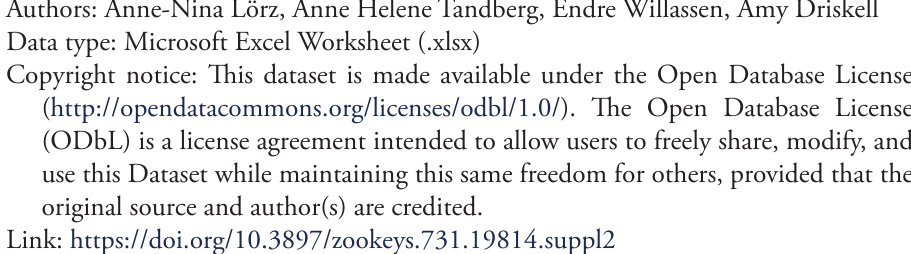
Table S2. Geographic distances between stations (sample name) in km.